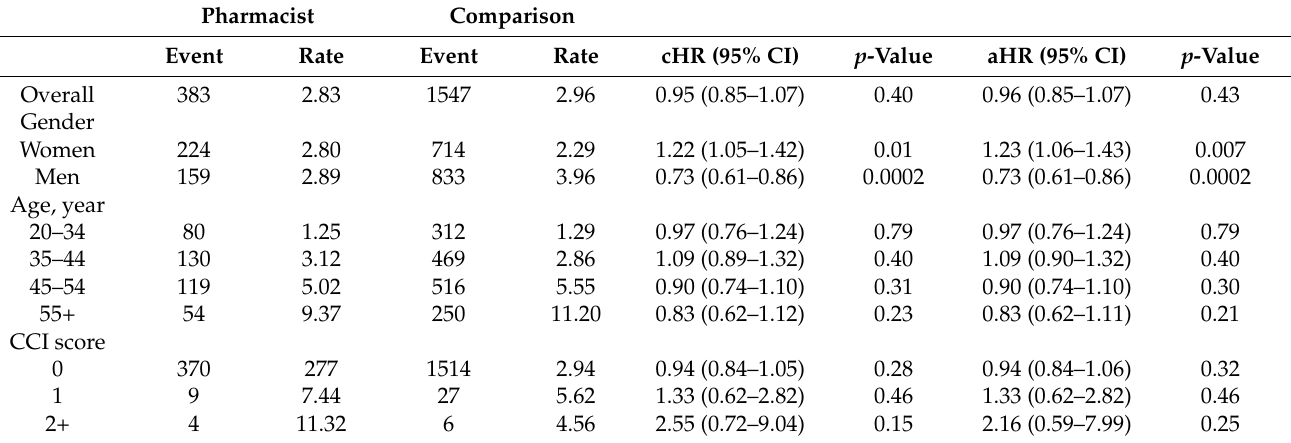
Table 2. Cancer incidence and risk stratified by gender, age and CCI